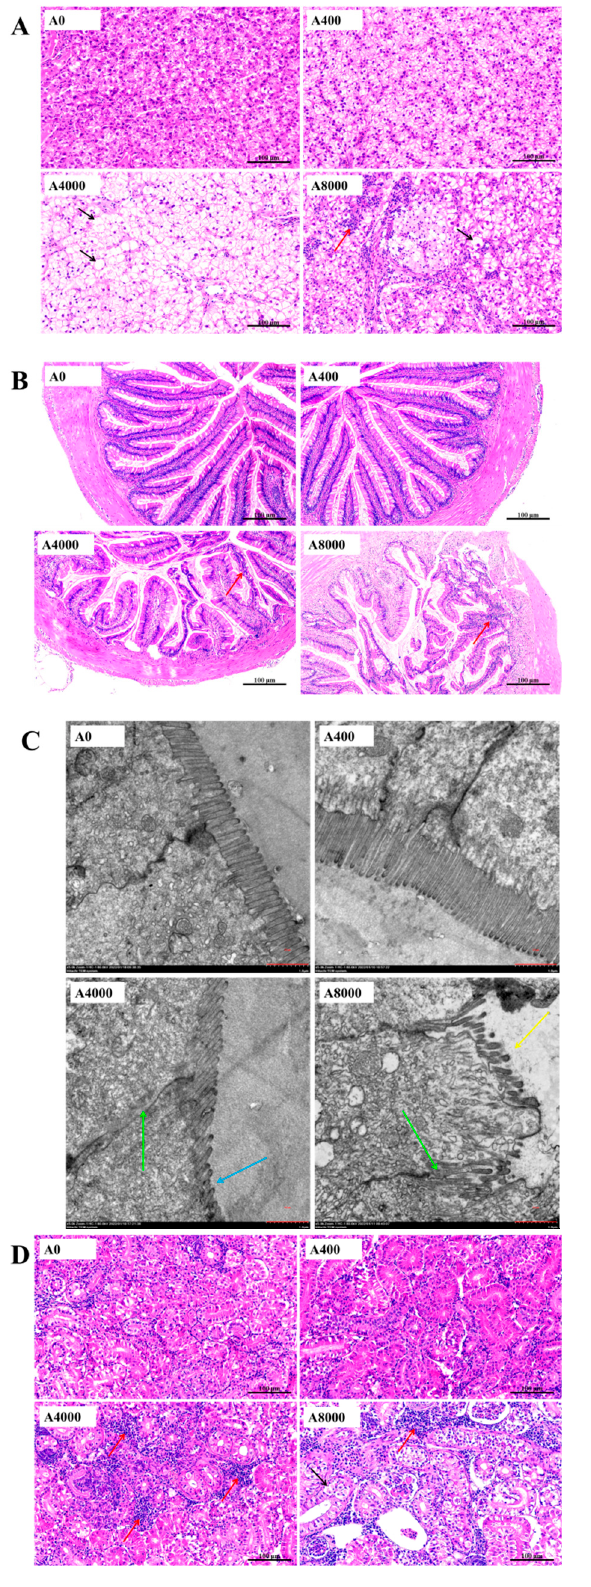
Figure 6. Effects of dietary AMP on histologic morphology of the liver ( A ), intestine ( B , C ), and kidney ( D ). Red row: inflammatory cell infiltration; black row: cell edema; green row: tight junctions; blue row: microvilli shrunk; yellow row: microvilli shed. Data are shown as mean ± SEM ( n = 6). Different lowercase letters represent significant differences among all groups ( p < 0.05).